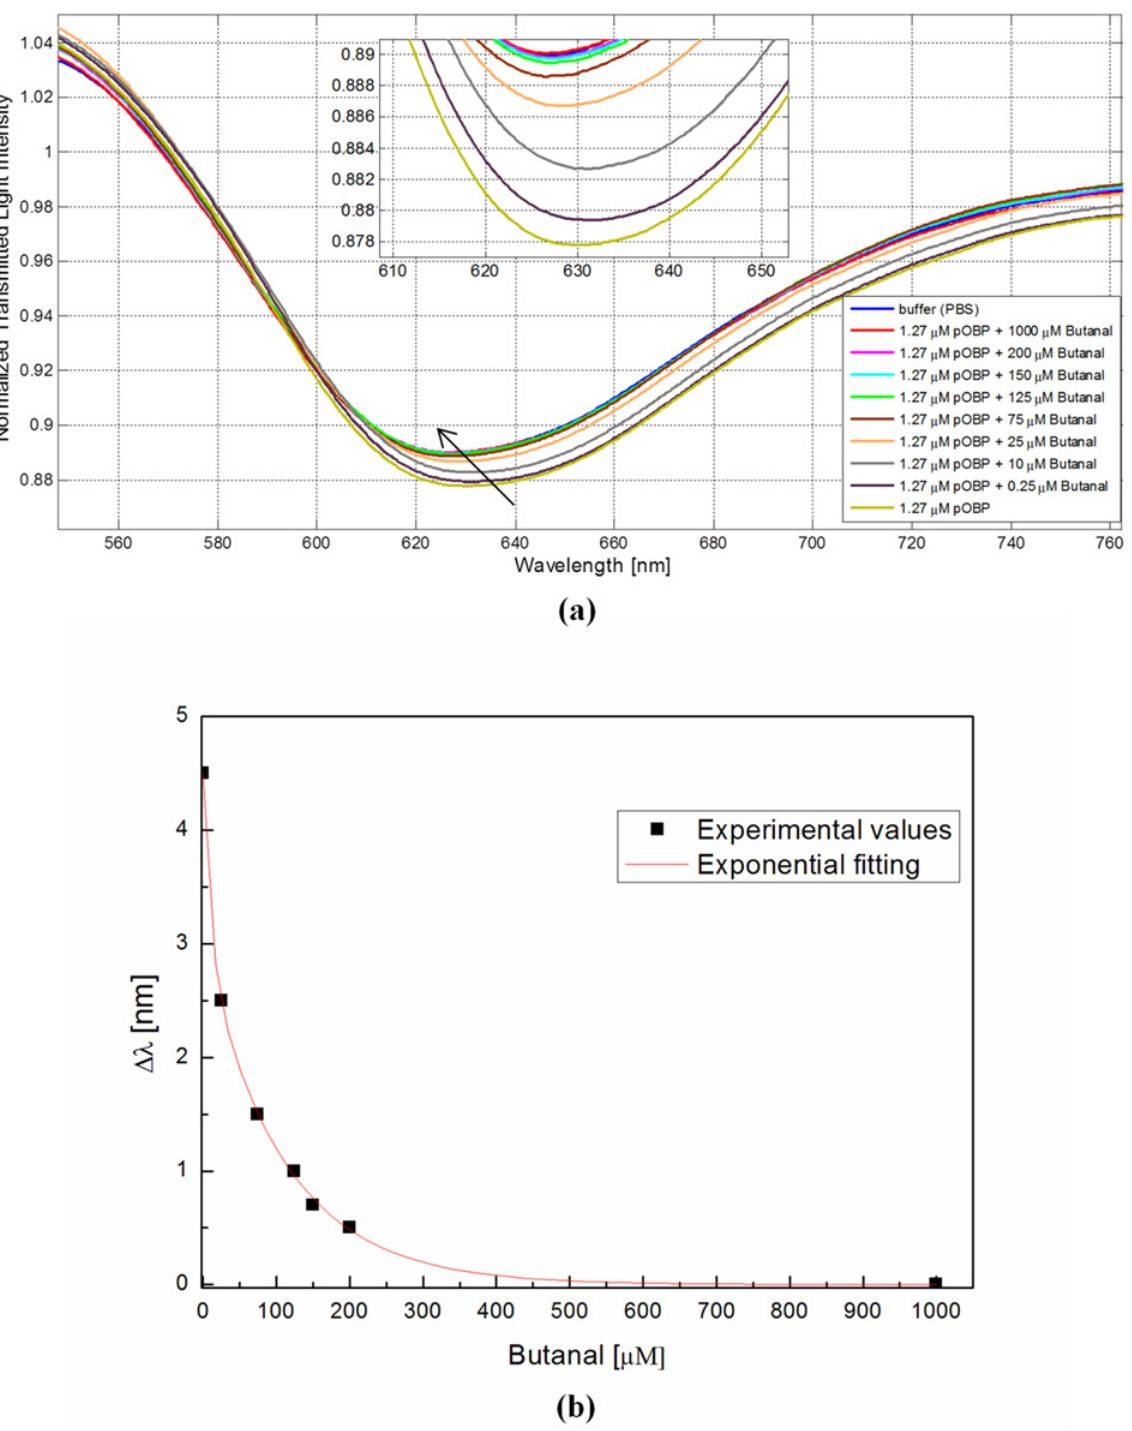
Fig 6. Competitive assay-SPR. (a) SPR transmission spectra, normalized to the air spectrum, for different concentration in solution of butanal and with a fixed concentrations of pOBP (1.27 μ M), in the case of sensor with gold layer with bio-receptor. Inset: Zoom of the resonance wavelengths region. (b) Resonance wavelength variation as a function of butanal concentration, obtained with binding of a fixed concentration of pOBP in presence of increasing concentration of butanal during pre-incubation time.